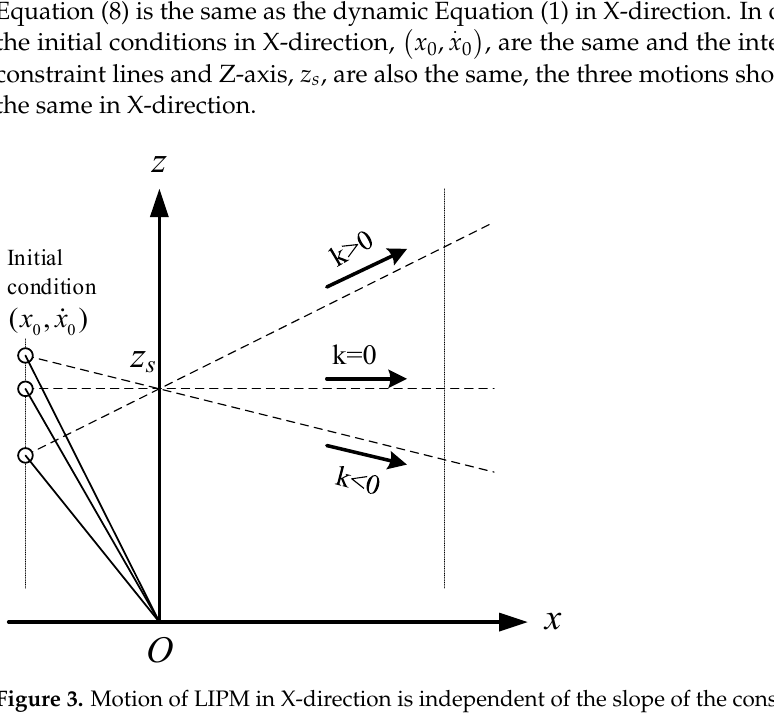
Figure 3. Motion of LIPM in X-direction is independent of the slope of the constraint